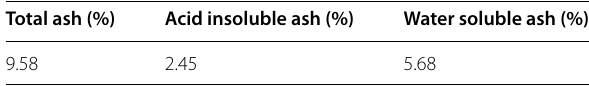
Table 5 Ash values of B. pinnatum stem